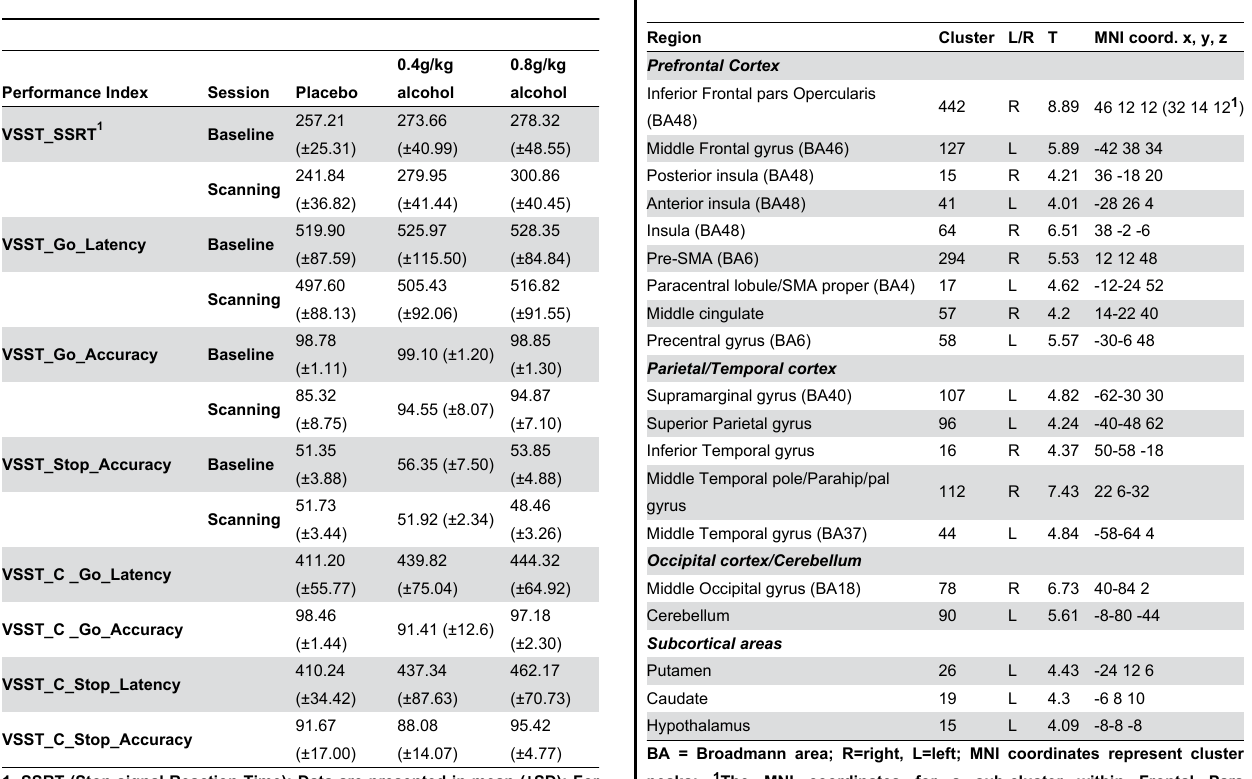
Table 4. Sstop>Go activations that were unaffected by exclusive masking with the Stop_VSST_C>Go_VSST_C contrast in the placebo group (p <.005, unc. k ≥ 13 voxels).